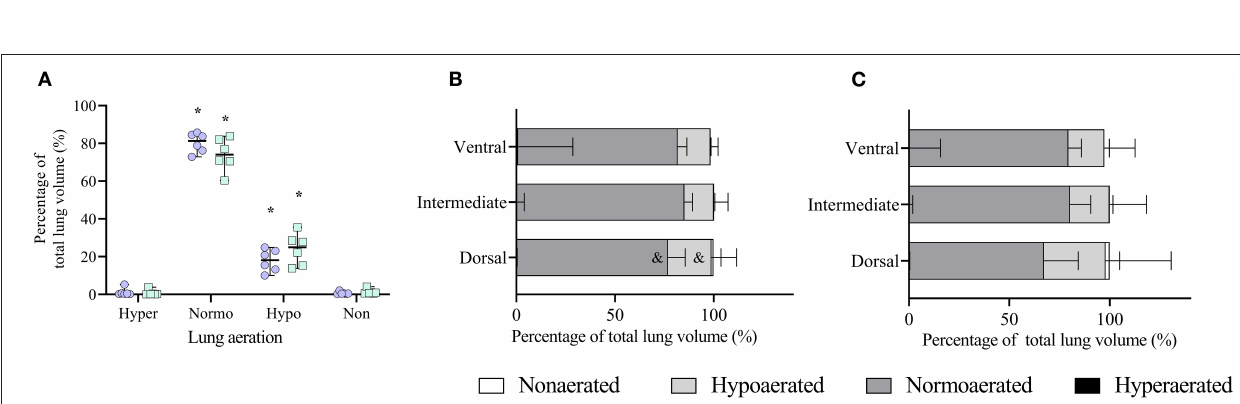
FIGURE 5 | Analysis of lung aeration data obtained by computed tomography (CT) scans during an end-inspiratory pause in six obese dogs undergoing anesthesia. (A) Whole end-inspiratory aeration is shown during ventilation with tidal volumes based on current (VTc, open circles) and ideal (VTi, open squares) body weight. Hyper, hyperaerated; Normo, normoaerated; Hypo, hypoaerated; Non, nonaerated. * p < 0.05 compared to the respective aeration during end-expiration ( Figure 4A ). (B) Regional end-inspiratory aeration during treatment VTc. & p < 0.05 compared to the respective aeration within the same region during end-expiration ( Figure 3B ). (C) Regional end-inspiratory aeration during treatment